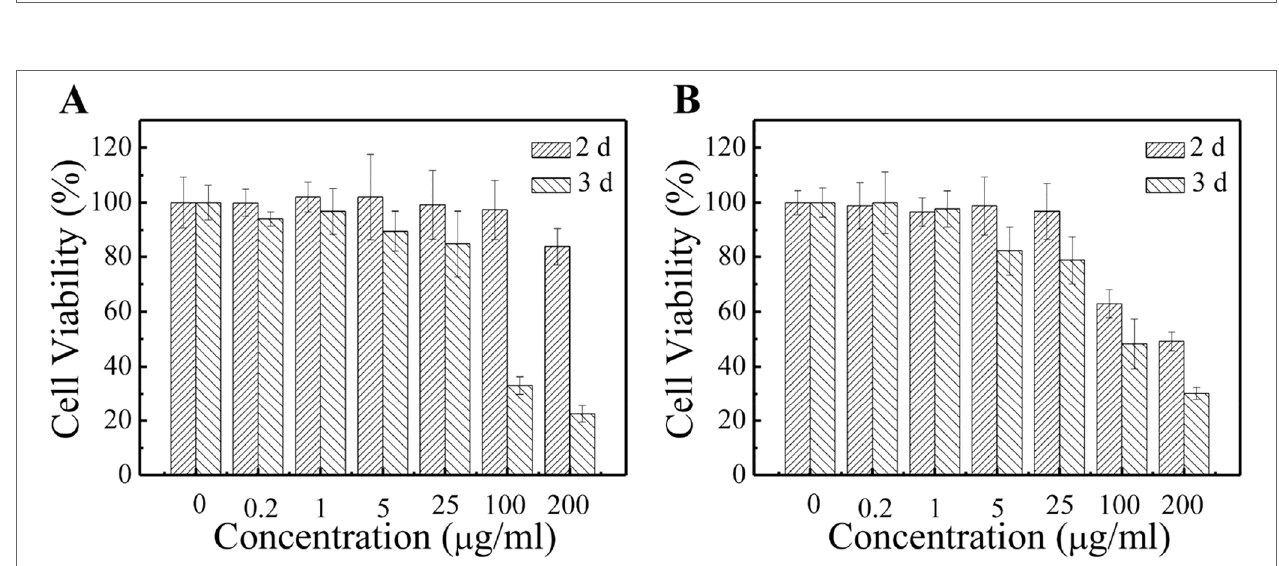
FIGURE 5 | The release of siRNA from PCL-PDEM/siRNA nanoplexes in the presence of poly(aspartic acid). (A) Agarose gel electrophoresis of the PCL-PDEM/ siRNA nanoplexes after dialysis with different minutes. (B) The cumulative release of